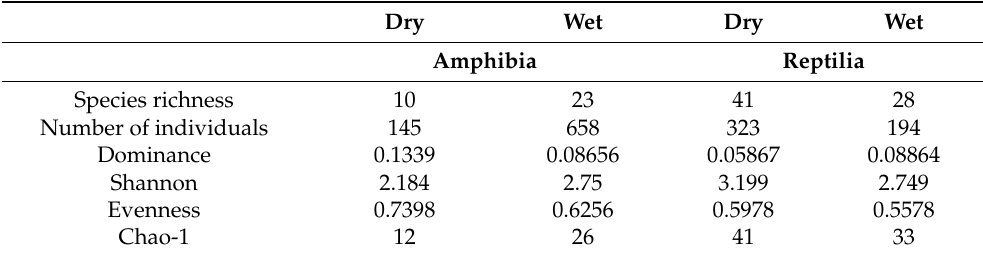
Figure 3. Saturation curves and diversity profiles (with 95% confidence intervals) for amphibians and reptiles during the dry and wet seasons. Saturation curves are ( a ) for amphibians and ( c ) for reptiles. Diversity profiles are ( b ) for amphibians and ( d ) for reptiles. Table 2. Diversity indices for amphibian and reptile communities at the study area during the wet and the dry